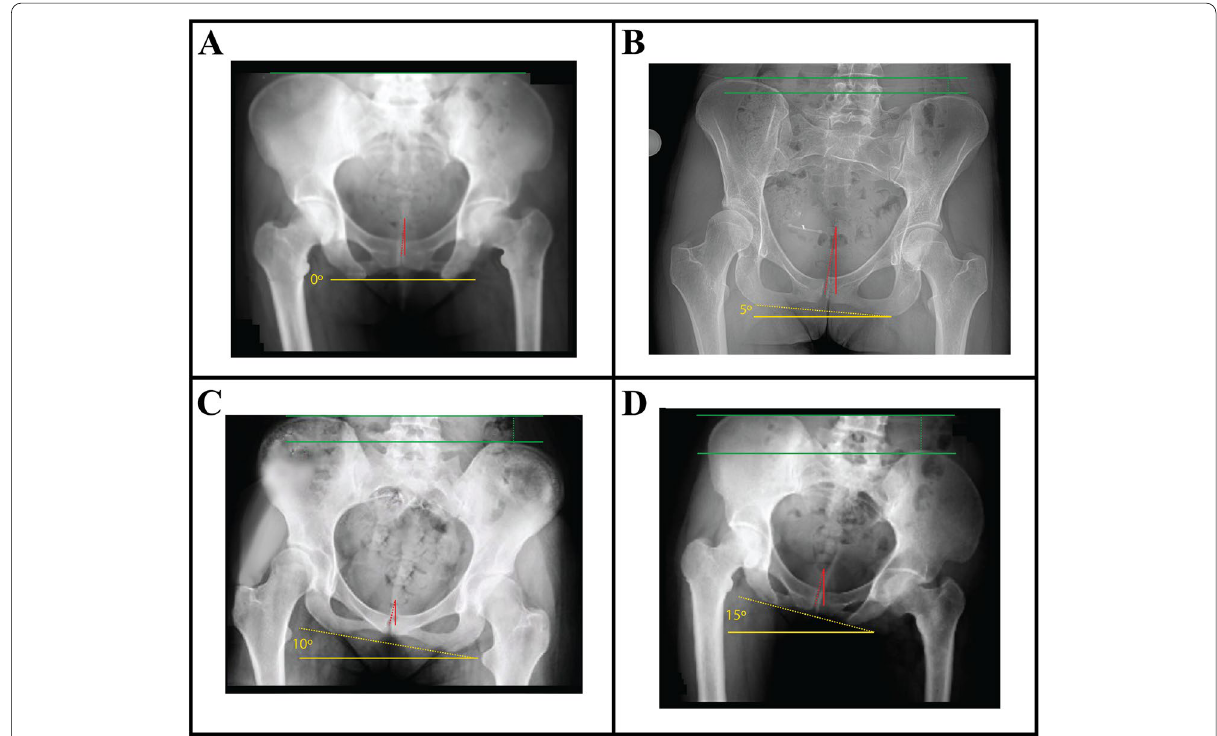
Fig. 10 A An AP pelvic radiograph of a patient with a level pelvis is shown. Notice the relative bilateral symmetry in the size and shape of the obturator foramina, the iliac wings, the ischial spines, and the ischial tuberosities. This symmetry, viewed in context of the relative vertical alignment of coccyx and the midline of the pubic symphysis gives us an overall impression of a lack of PO. B A PO of 5° is seen in this radiograph. Notice the bilaterally asymmetric heights of the iliac crests and the relatively increased vertical malignment of the tip of the coccyx and the midline of the pubis compared to the neutral pelvis. C At a PO of 10°, the asymmetry between the bilateral obturator foramina and the heights of the iliac crest become much more profound. D Demonstrating even greater postural asymmetry, this radiograph shows a PO of